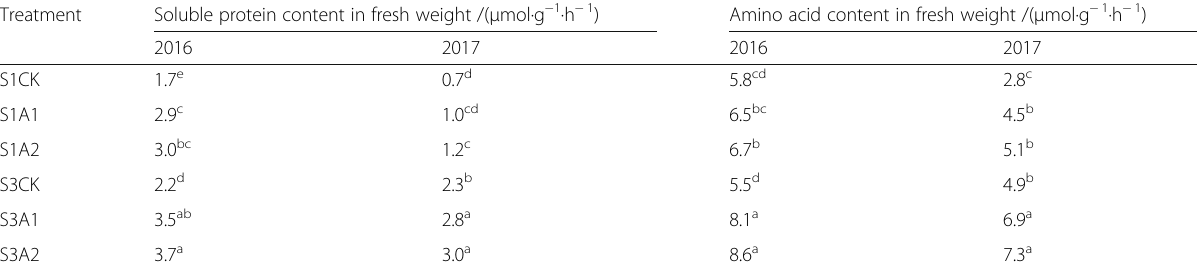
Table 3 The effect of application of 5 amino acids and 21 amino acids on flower soluble protein and amino acid content of the two Bt cotton cultivars at flowering period Treatment